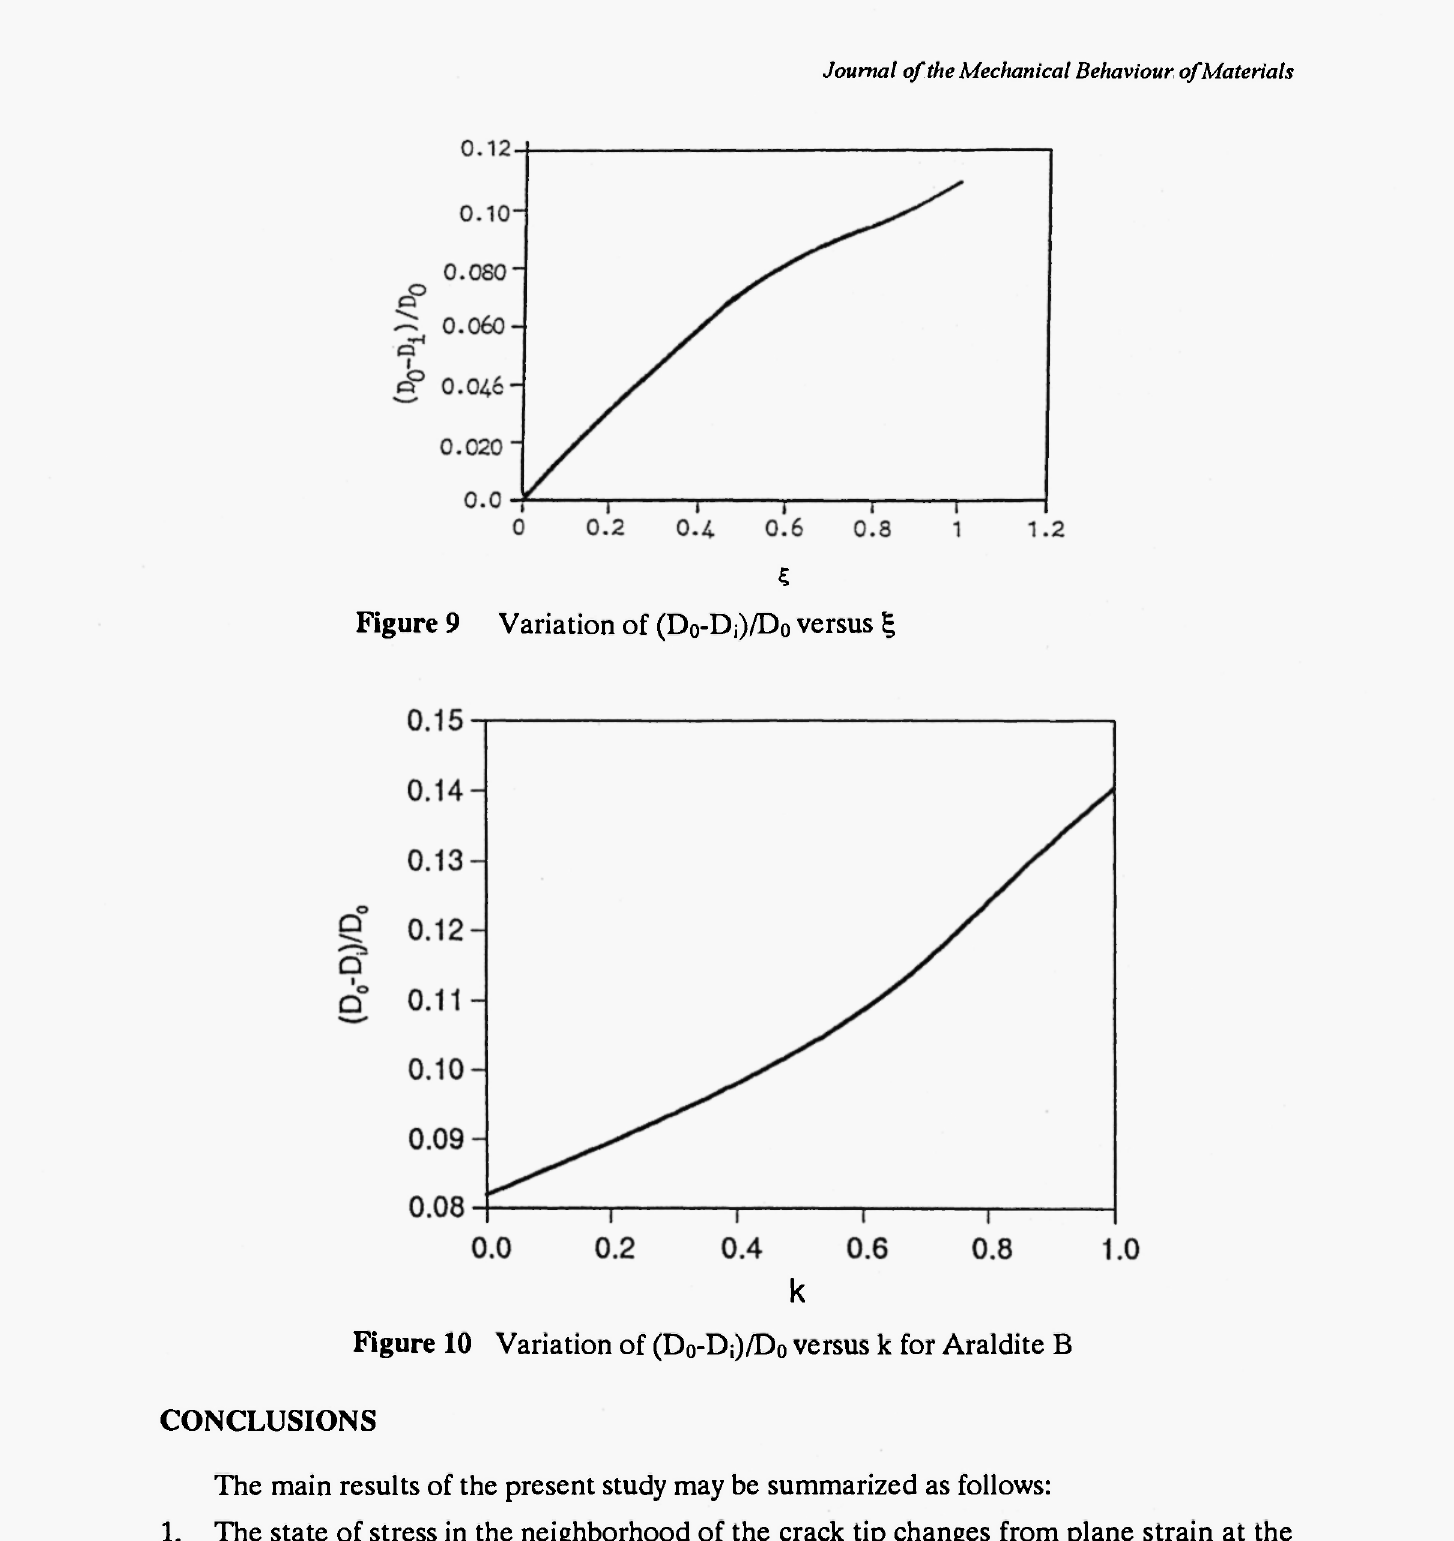
Figure 10 Variation of (D